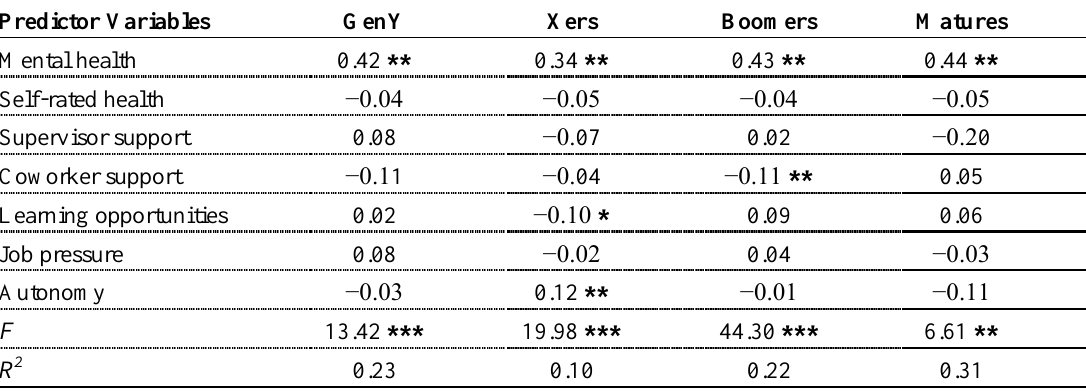
Table 4. Regressions for family interfering with work (FIW) on predictor variables by generational